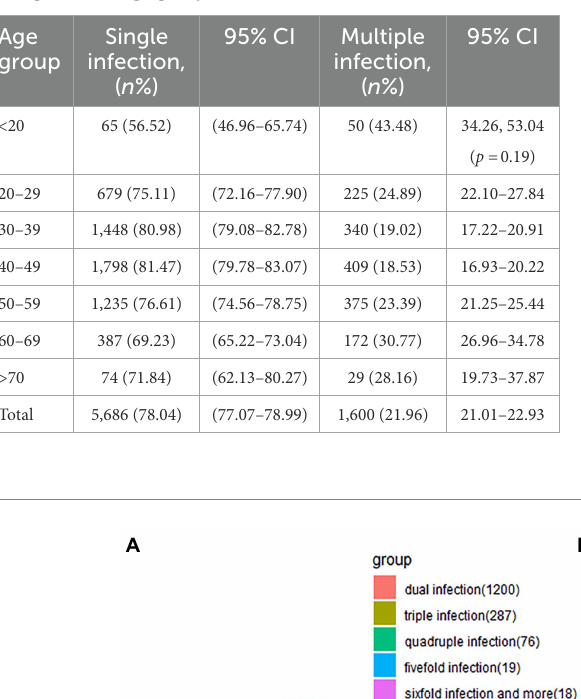
TABLE 3 Distribution of single-type and multiple-type infection among different age groups.